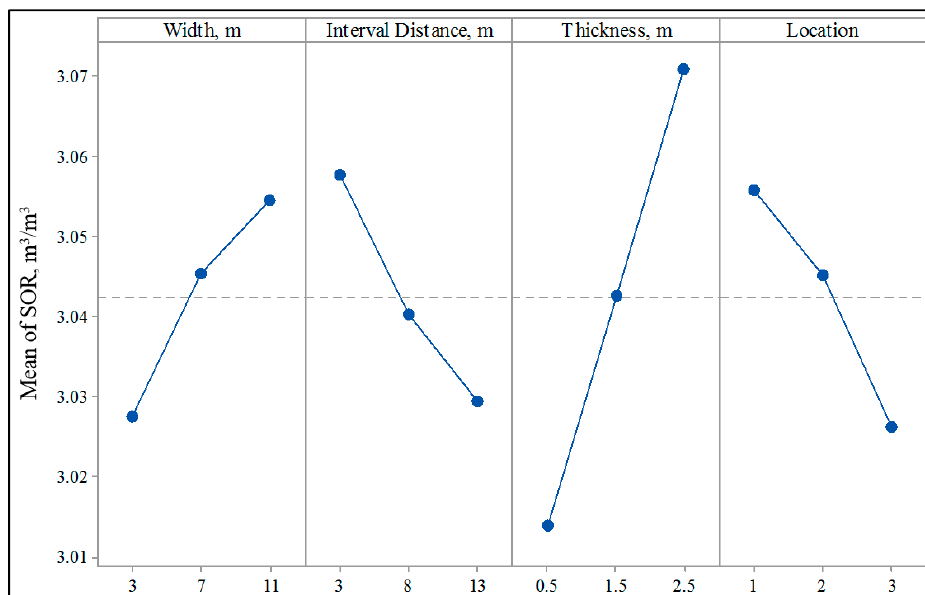
Figure 4. Main effect analysis of SOR for all cases.